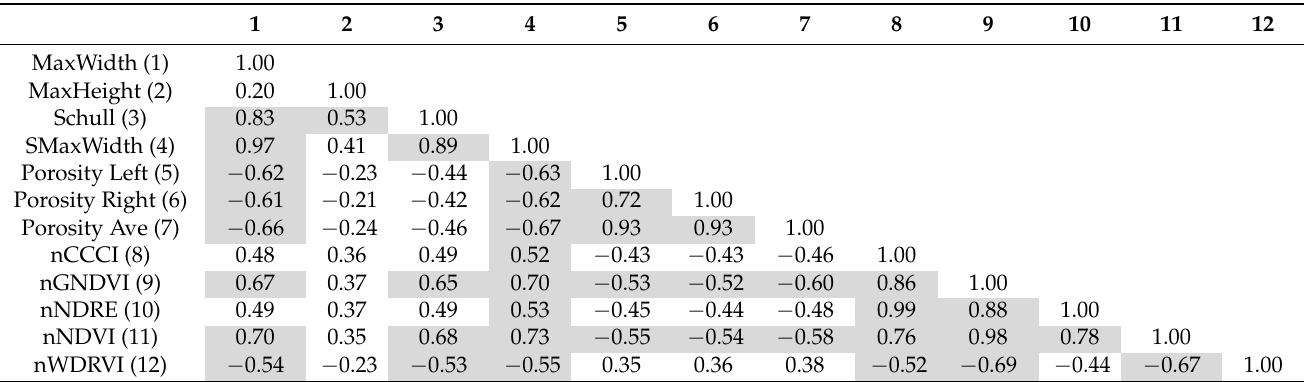
Table 3. Correlation coefficients between the analyzed variables. Spectral indices are normalized values using a delimiter mask. N = 4027. In grey, correlations above/below ± 0.5 ( p -value < 0.01 for all the